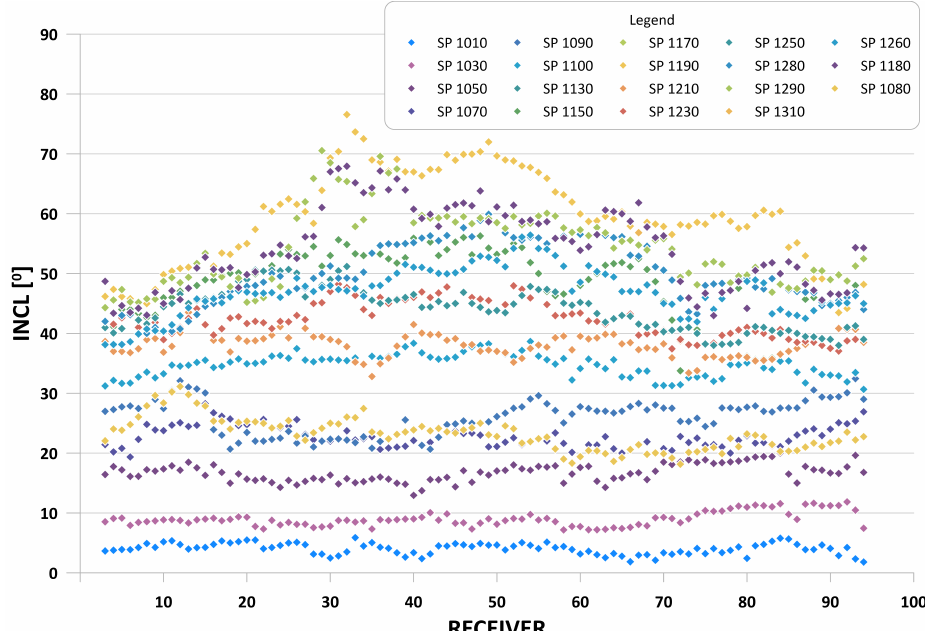
Figure 12. P-wave polarization angle distributions for different shot points (SP 1010 represents the nearest offset, and SP 1310 represents the farthest